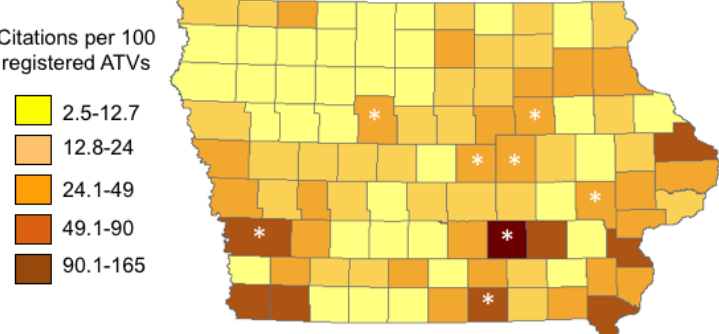
Figure 2. Mapping of citations by county. The total number of citations per county from 2005-2015 were calculated. Values were normalized per 100 registered ATVs and mapped using ArcGIS. Asterisk indicates a county with an off-road vehicle (ORV) park. Table 6. Binary logistic regression analysis of citation data from the Iowa Courts Information System (ICIS) from 2005–2015. Both models included 4594 cases for which there were no missing values for any of the covariables. Charge Disposition Counties with OHV Parks vs. (Guilty vs. Not Guilty) Those Covariables